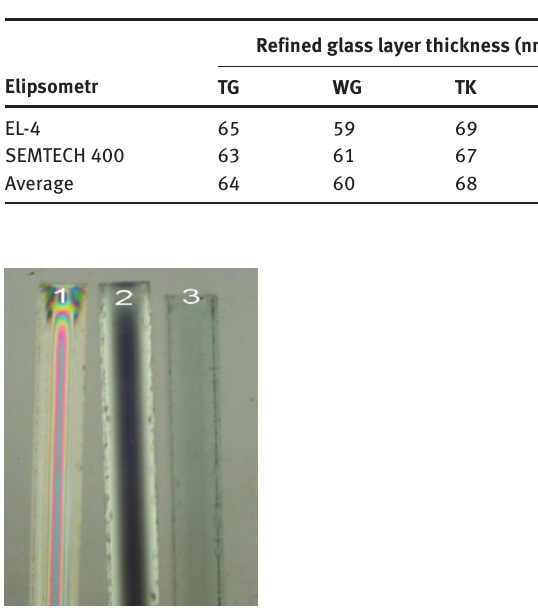
Table 2: Studied glasses layer thickness measurement results